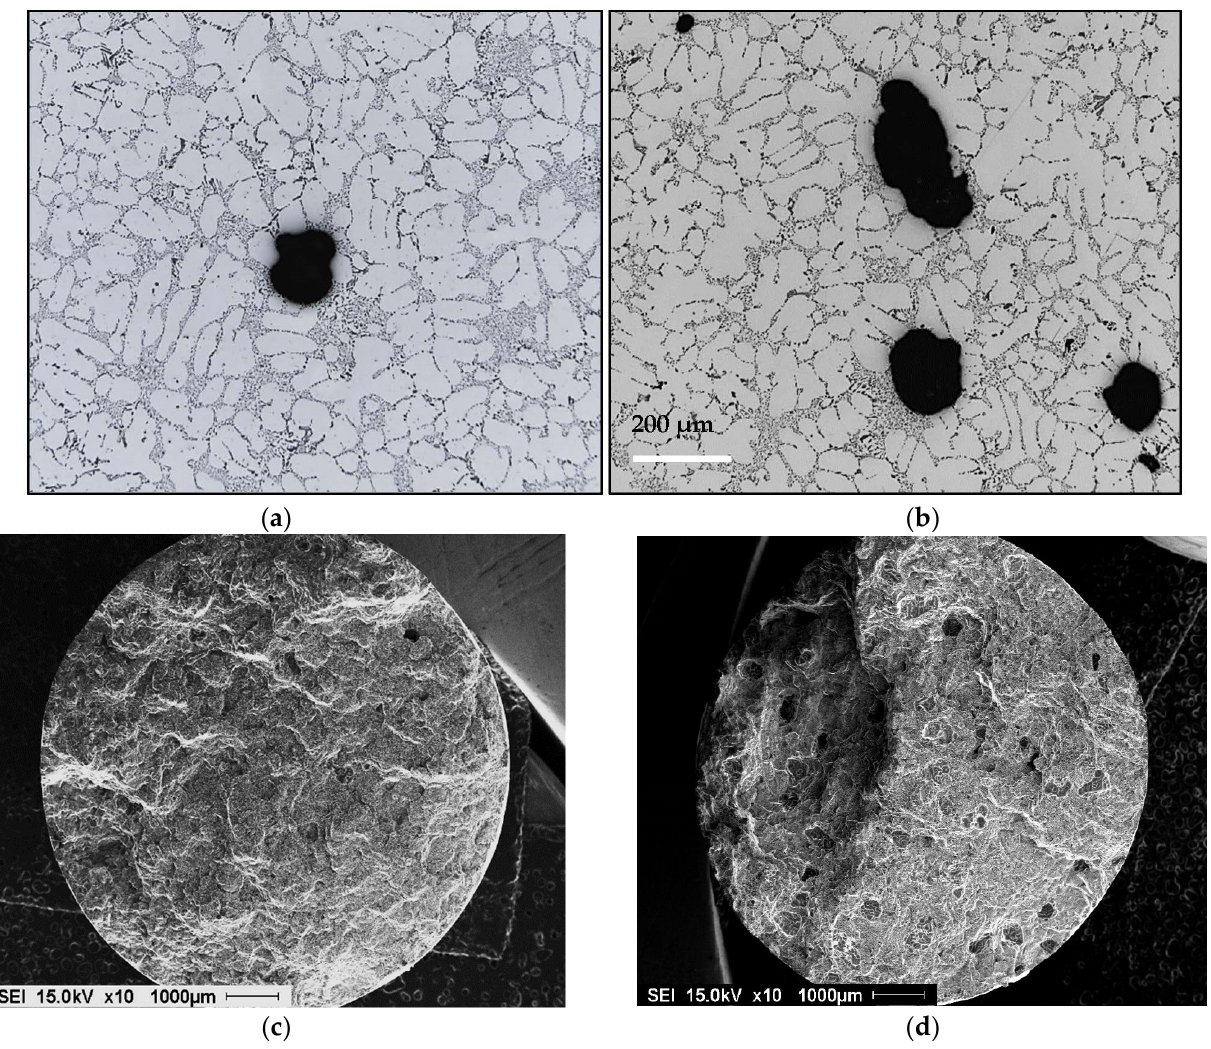
Figure 2. Optical microstructure of porosity in 319 alloy ( a ) low hydrogen 0.12 mL/100 g Al, ( b ) high hydrogen 0.25 mL/100 g Al, ( c ) and ( d ) fractured surfaces of tensile bars corresponding to ( a ) and ( b ), respectively.